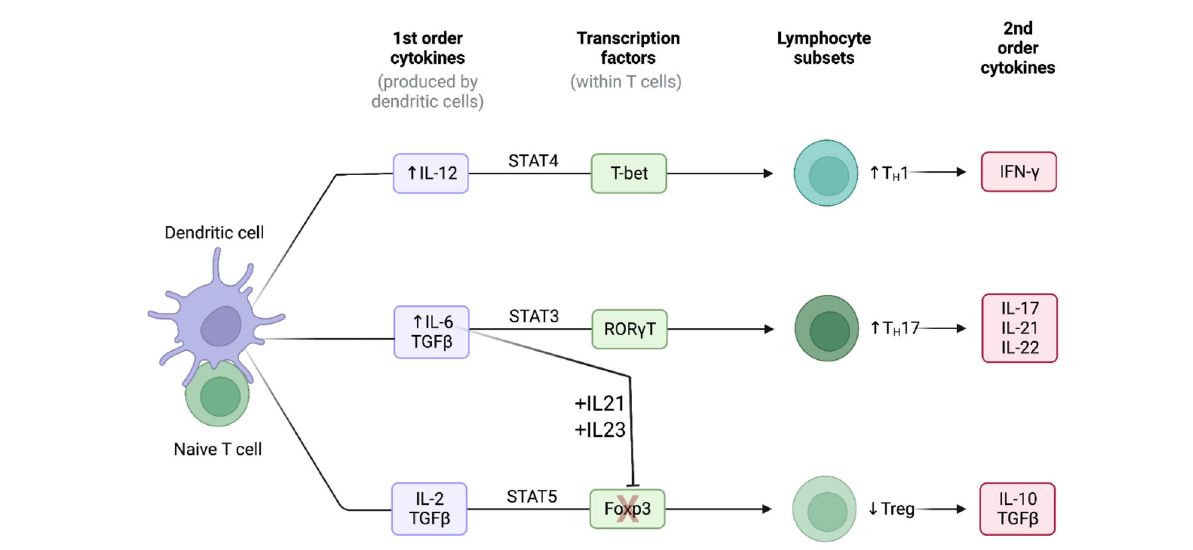
FIGURE2 Cytokine signatures in GCA. Lineage polarization of naive T-cells in giant cell arteritis. Created with BioRender.com. Adapted from “Induction of 2nd order cytokines”. Retrieved from https://app.Biorender.com/biorender-templates.